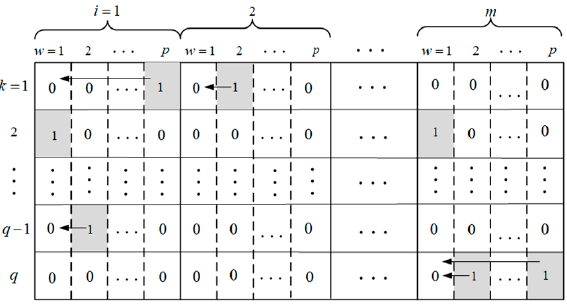
Figure 4. Searching space of the channel allocation problem.